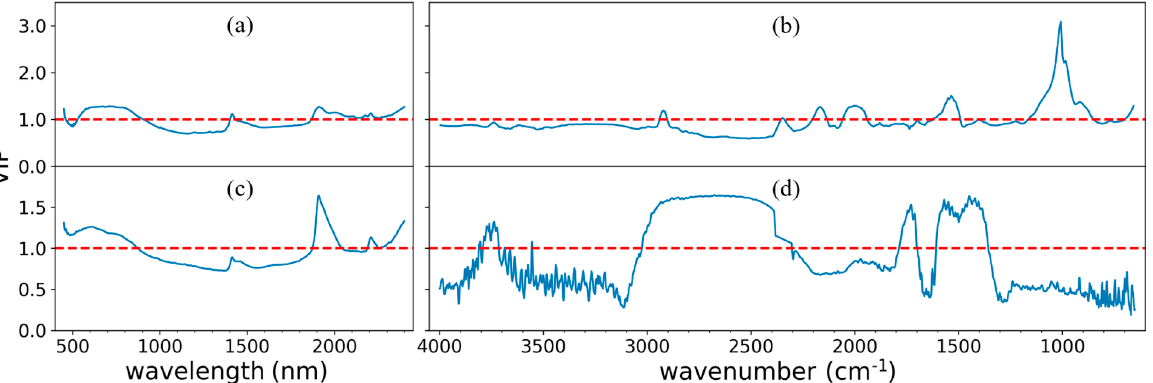
Figure 8. VIP scores of each wavelength derived from PLSR: ( a ) in situ vis-NIR; ( b ) in situ MIR; ( c ) laboratory vis-NIR; ( d ) laboratory MIR.